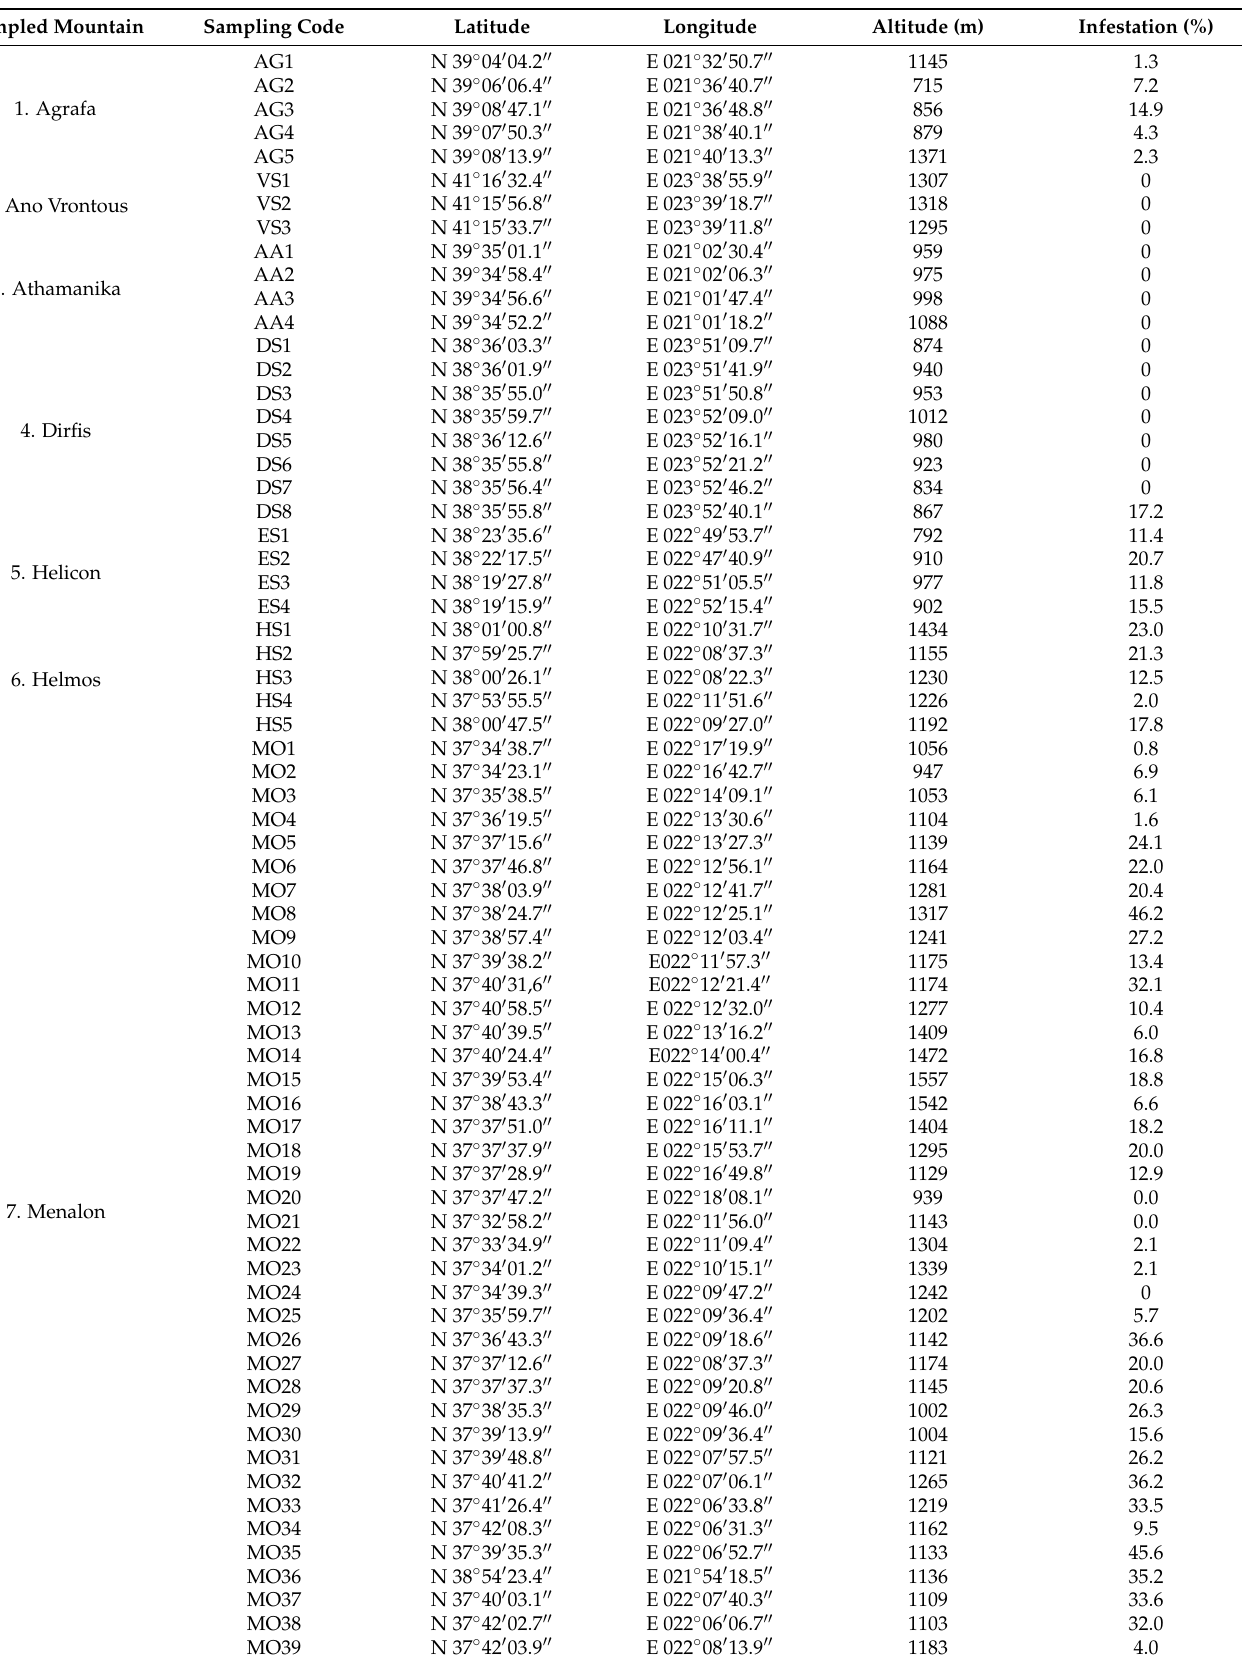
Table 1. Coordinates of sampling points and percentage infestation [I (%) ] of Abies spp. samples by P. hellenicus . Sampled Mountain Sampling